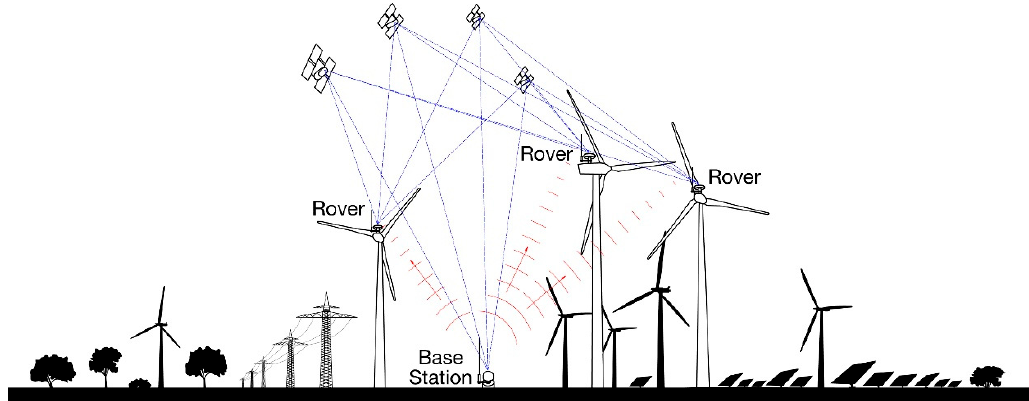
Figure 2. Schematic of real-time kinetic (RTK)-global navigation satellite system (GNSS) method.